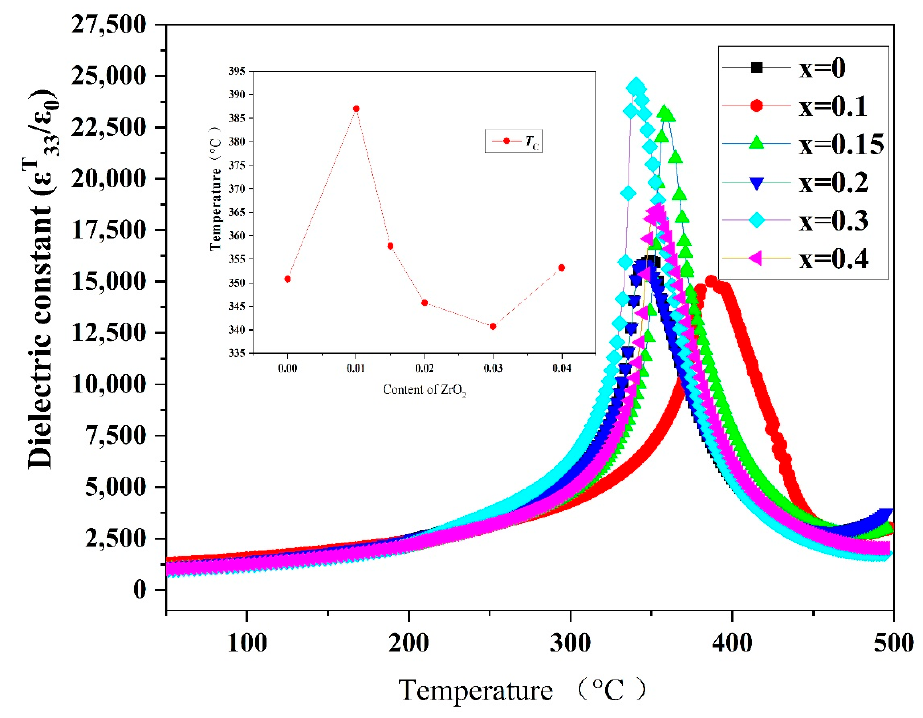
Figure 10. Dielectric thermograms (1 kHz) of PZTN ceramics sintered at 1260 °C for 2 h.